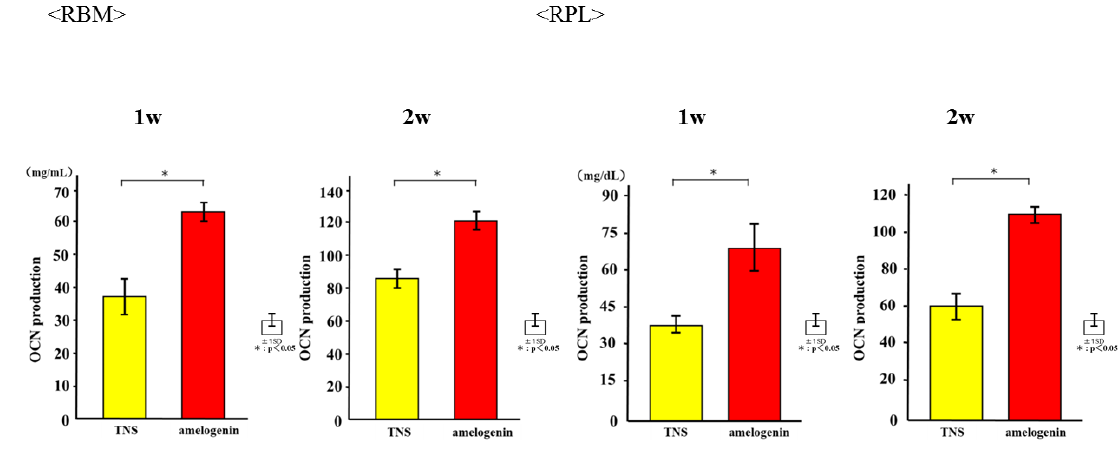
Figure 10. OCN production in control and test groups. * p < 0.05.